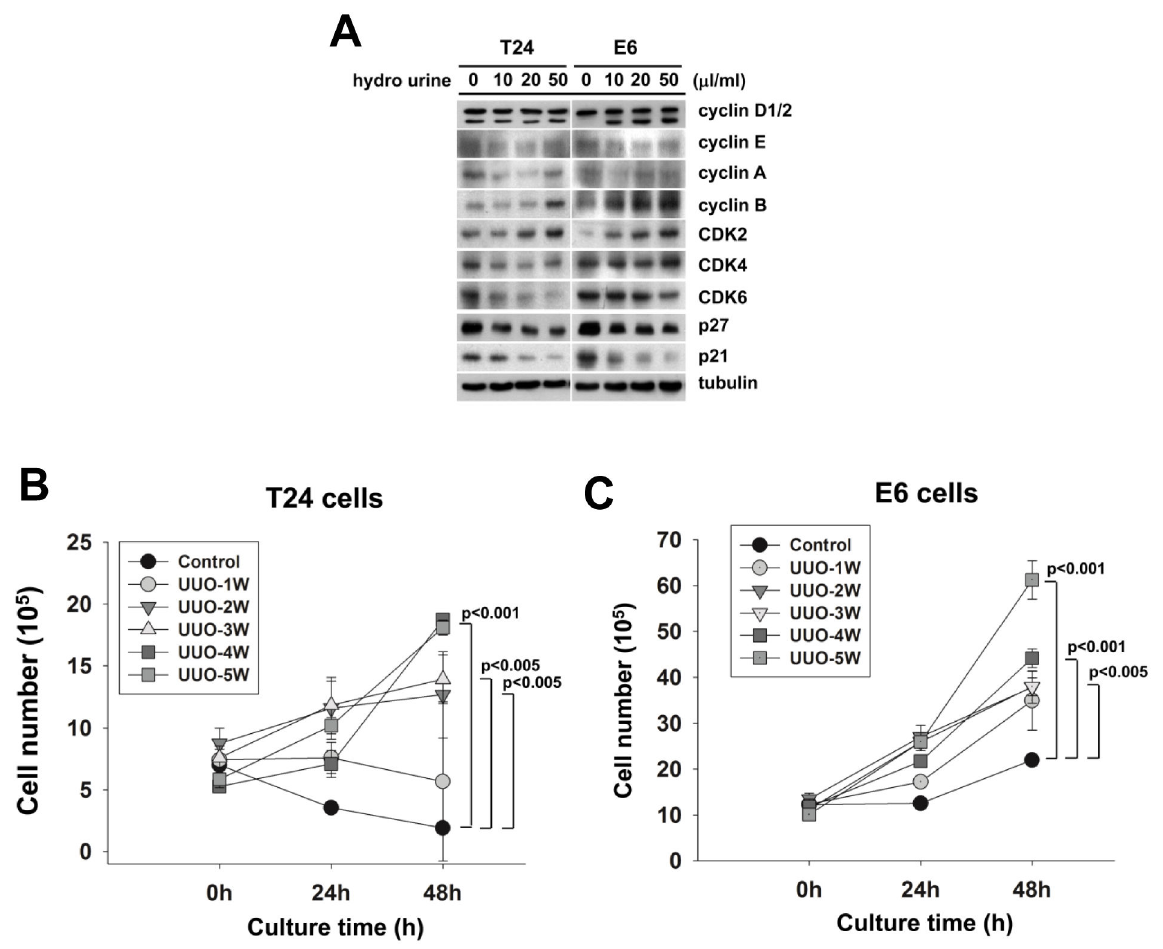
Figure 1. Hydronephrotic urine induced the expression of the cell cycle-regulated proteins and promoted the proliferation of T24 cells and E6 cells. (A) T24 cells and E6 cells were cultured in the hydronephrotic urine (10, 20, 50 µl/ml) at 3 weeks after UUO following serum starvation for 24 hrs. The expressions of cell cycle regulated proteins were analyzed by western blotting. (B) T24 cells were cultured in the hydronephrotic urine from 1, 2, 3, 4 and 5 weeks after UUO under serum starvation. Hydronephrotic urine at 2, 3, 4 and 5 weeks after UUO promoted cell proliferation but hydronephrotic urine did not promote T24 cells proliferation at 1 week after UUO (Control: without hydronephrotic urine treatment). (C) E6 cells were cultured in the hydronephrotic urine from 1, 2, 3, 4 and 5 weeks after UUO. Hydronephrotic urine at 1 to 5 weeks after UUO promoted proliferation of E6 cells (Control: without hydronephrotic urine